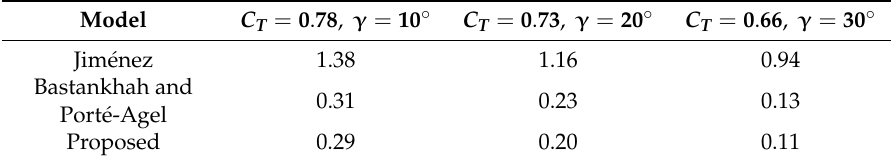
Table 4. NRMSE of predicted wake